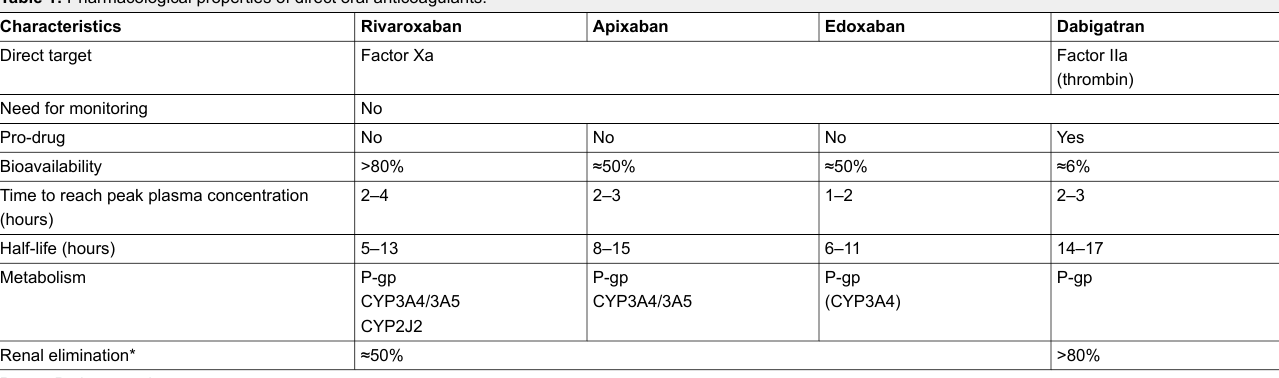
Table 1: Pharmacological properties of direct oral anticoagulants.